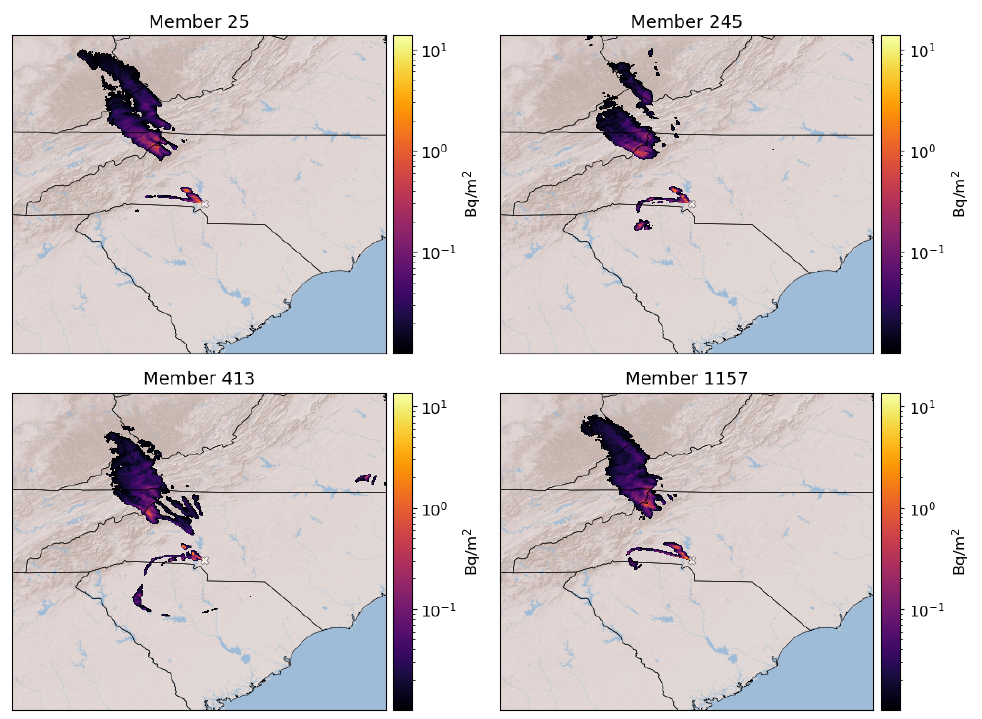
Figure 3. Examples of different deposition maps produced by FLEXPART-WRF for the elevated release case. All values below 0.01 Bq/m 2 were removed. The WRF parameterizations used to create each subplot can be found in Section